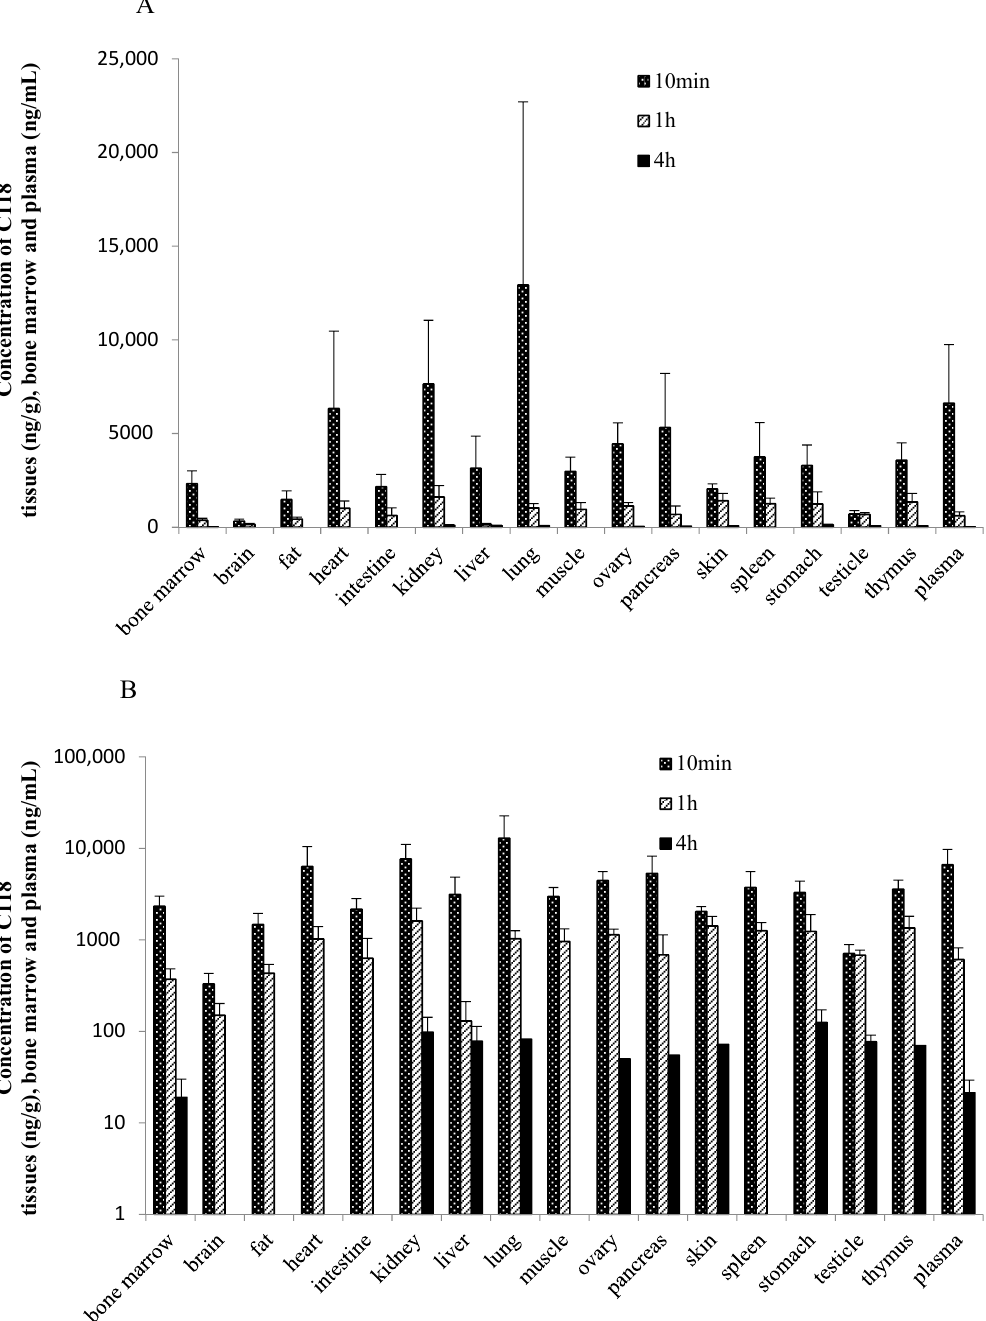
Figure 3. C118 concentration (ng/g, ng/mL) in rat tissues at 10 min, 1 h and 4 h after i.v. administration of C118P at 20 mg/kg. Data are presented as the arithmetic mean ± SD ( n = 6). ( A ) The normal scale; ( B ) the semi-logarithm scale.